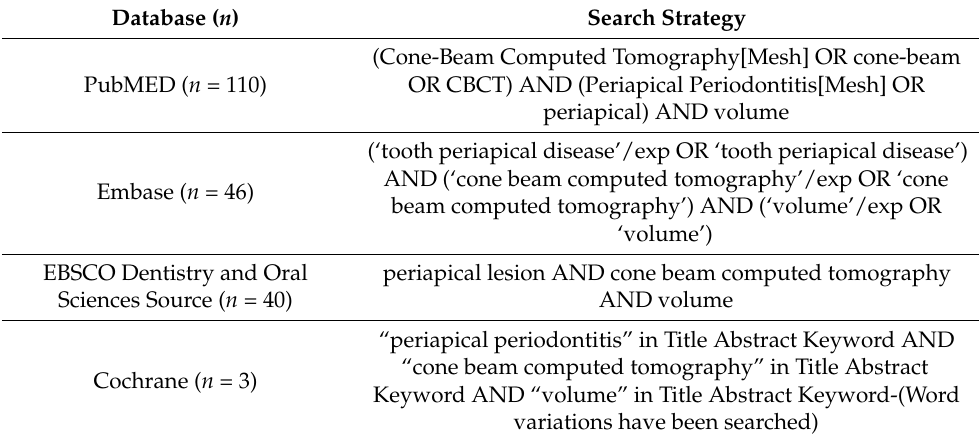
Table 1. Search strategy in